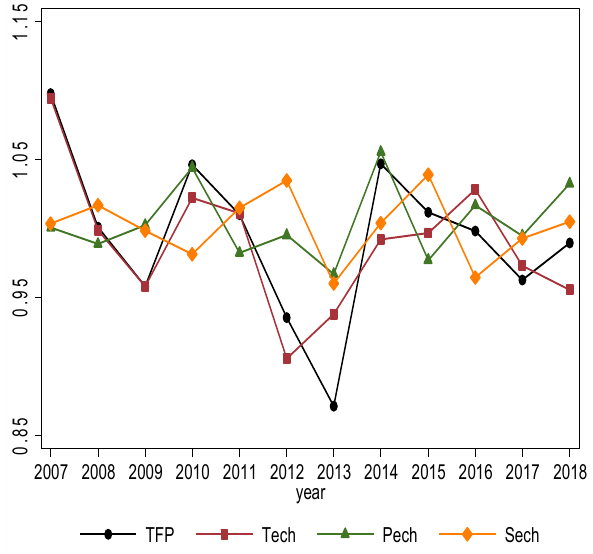
Figure 5. Trends in Production Efficiency of Medium Indica Rice from 2007 to 2018. Table 8. Factors Influencing Production Efficiency and Its Decomposition Index of Medium Indica